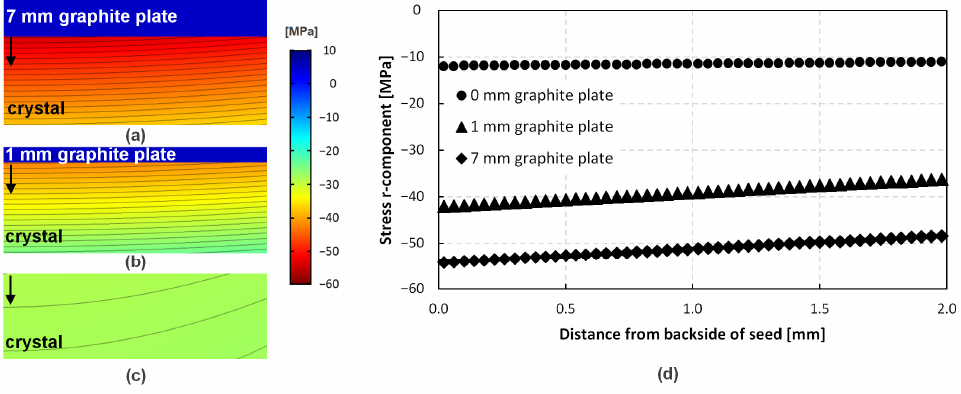
Figure 7. Numerical simulation depicting the r-component stress field of a 21 mm crystal cooled down to room temperature from growth temperature, attached to a ( a ) 7 mm graphite plate; ( b ) 1 mm graphite plate; ( c ) with a carbon-based backside coating. ( d ) illustrates the dataset taken at the positions of the arrows in ( a – c ).